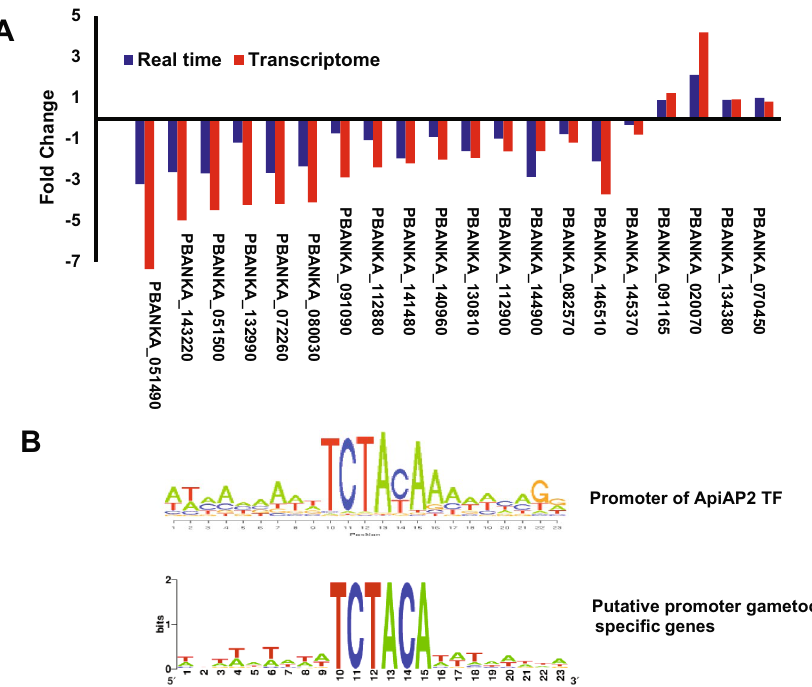
Figure 6. Transcriptomic Analysis of the ΔHspJ62 parasite line. ( A ) For validation of NGS data, qPCR was performed on 20 randomly selected up/downregulated genes from independent biological replicates of the experiment. GAPDH was taken as housekeeping genes. Blue and brown bars represent the fold changes (log10 scale) in P. berghei genes observed by qPCR and NGS, respectively. ( B ) The transcriptional regulatory motif of eight bases, i.e. TCTANAAA was identified upstream of the first ATG codon in gametocyte-specific